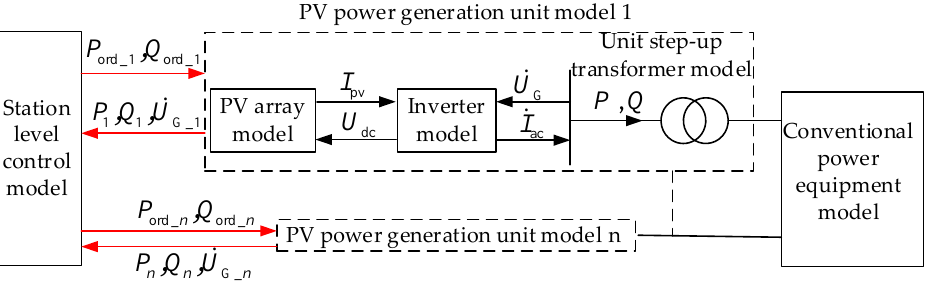
Figure 2. Electromechanical transient model framework.